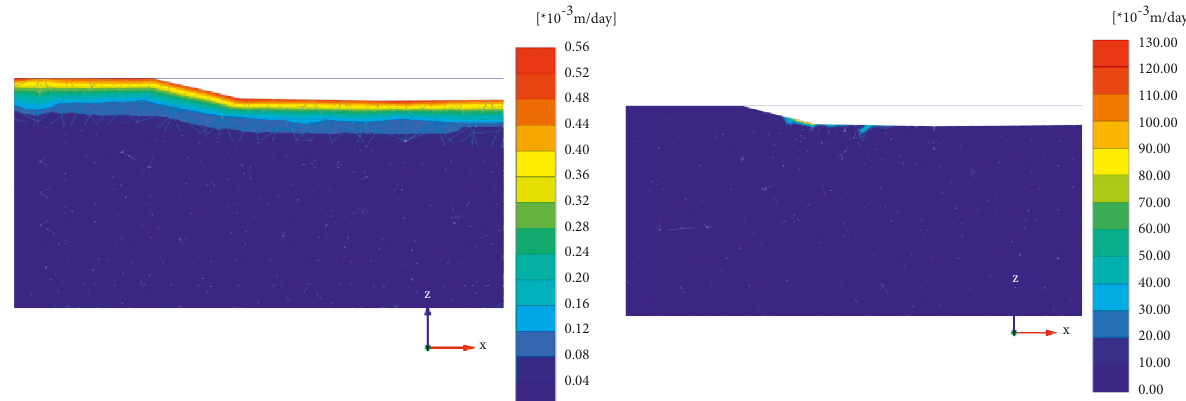
Figure 13: Cloud map of seepage field of drainage ditch at slope